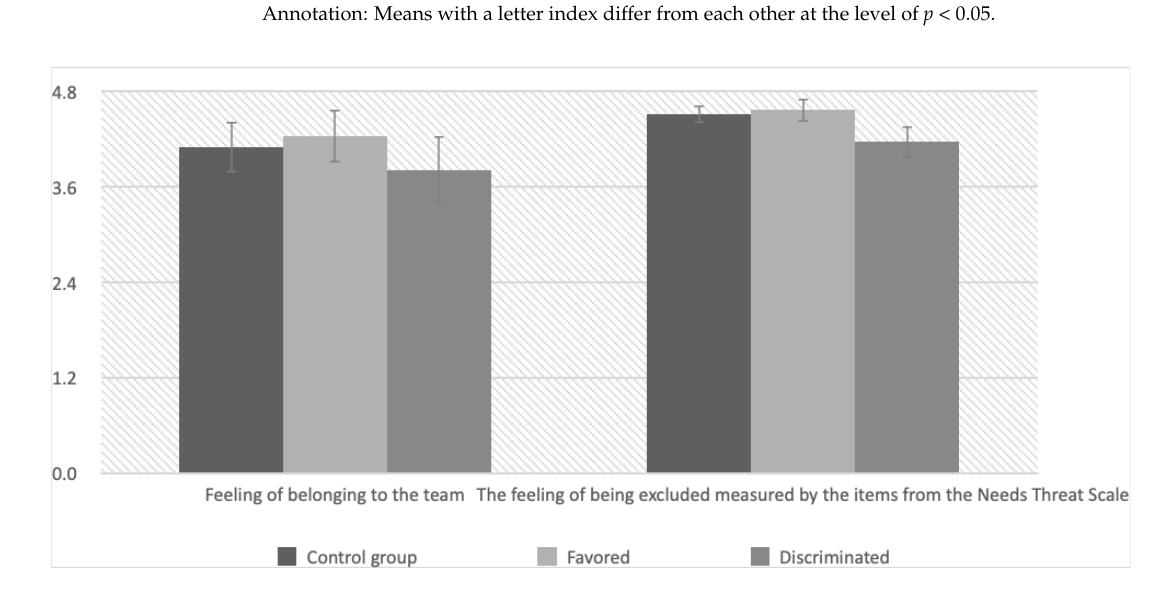
Figure 4. Means with 95% confidence interval for the robot’s likeability variable and indicator of its subjective assessment.